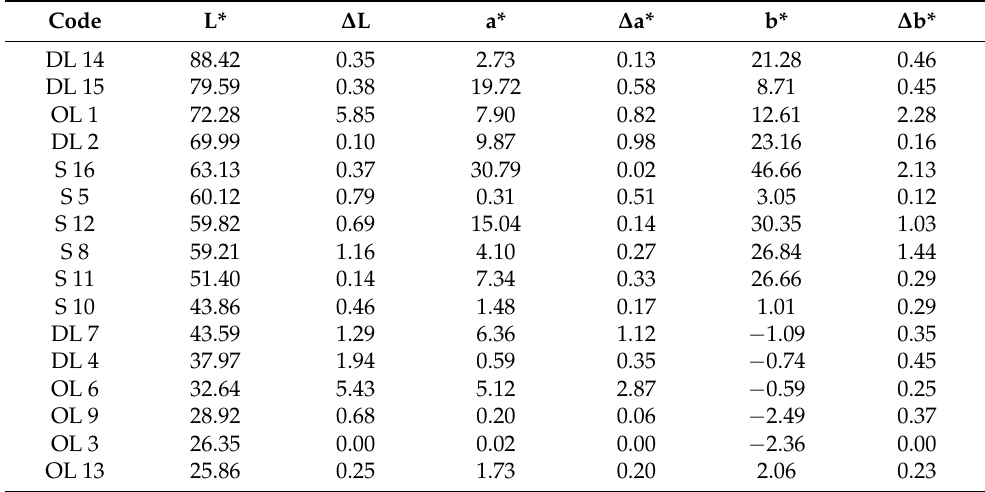
Table 9. Average color measurements of Background 2 sorted from largest to smallest